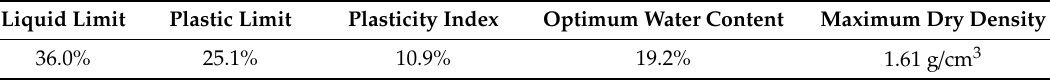
Table 2. Physical indicators of the modified